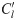
Overview diagram of pincram workflow.Step numbers in the text correspond to numbered boxes. C
l: pre-selection fused mask;M
l: tight margin (boundary neighborhood) mask; F
l: fuzzy label summed from rank-selected subset; Cl′: brain mask generated from F
l by thresholding and binarization; Ml′ wide margin mask generated from F
l by thresholding and binarization